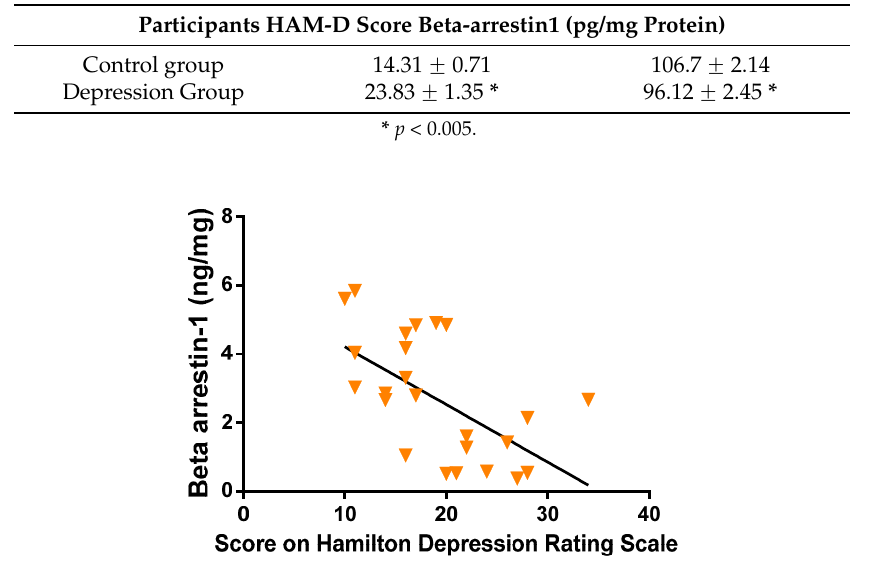
Table 1. The beta-arrestin1 levels in the leukocytes were compared with the independently obtained HAM-D score.